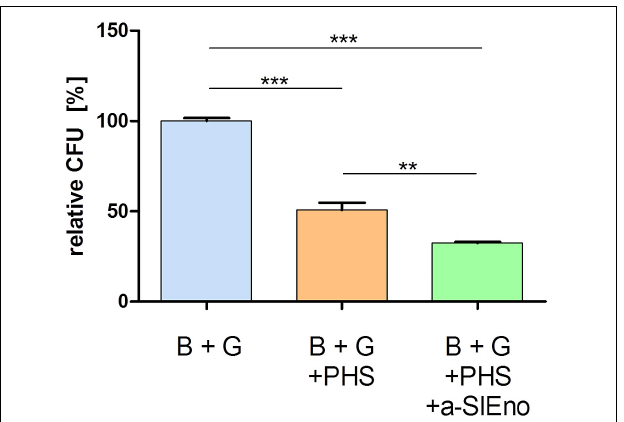
FIGURE 10 | Killing of S. lugdunensis by granulocytes in the absence and presence of pooled human sera and anti-SlEno Abs. Exponentially grown S. lugdunensis cells (B) and freshly prepared granulocytes (G) were mixed in 0.5 ml of Dulbecco’s modified Eagle’s medium and incubated solely, with pooled human sera (PHS) or PHS plus anti-SlEno antibodies (a-SlEno) for 60 min. Afterward aliquots of bacteria were platted on blood agar plates, and the number of CFUs were determined. Shown are the relative CFUs of B + G + PHS and B + G + PHS + a-SlEno compared with the CFUs of B + G. Results are shown as the mean of three independent experiments with the standard deviation (SD). Statistical analyses were performed using one-way ANOVA with Bonferroni multiple comparisons post-test (** p < 0.01, *** p <